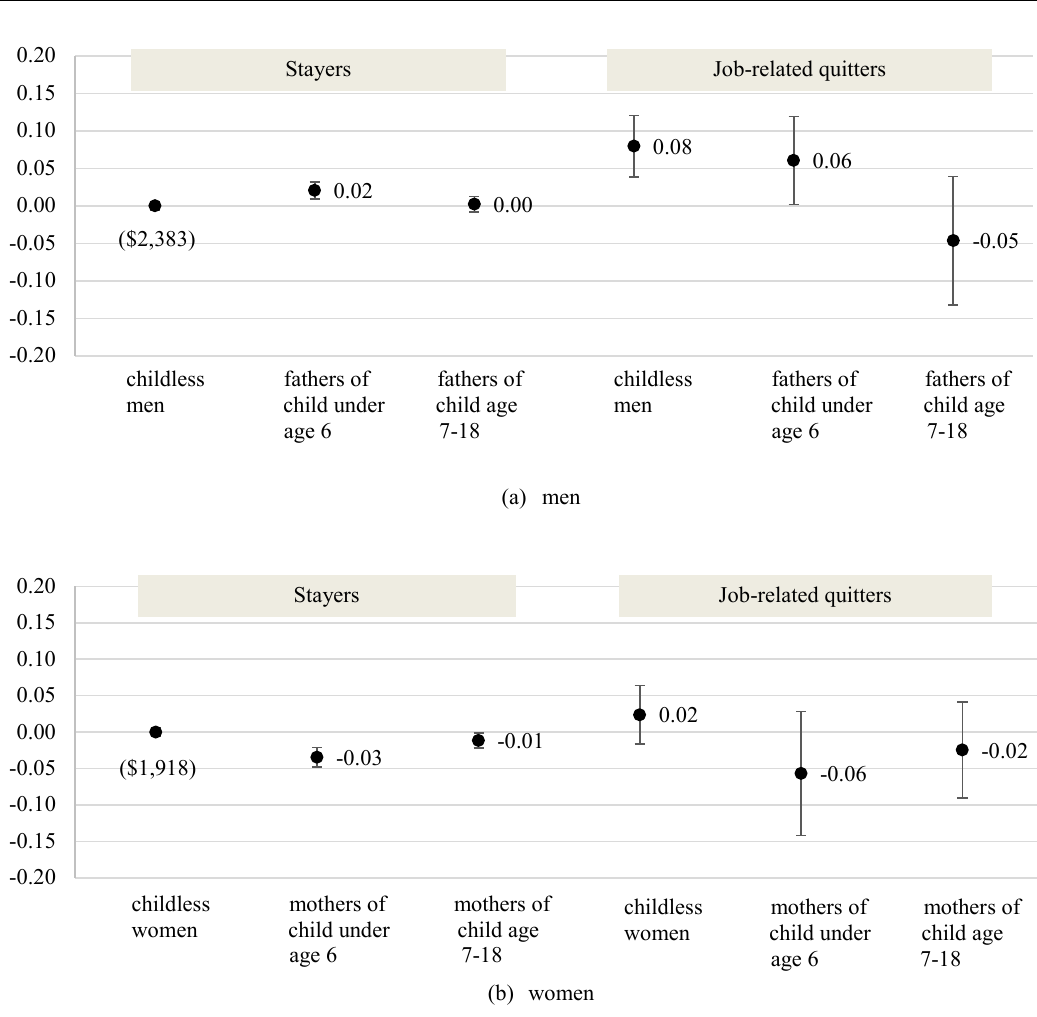
Figure 3. Differences in logged monthly earnings between childless stayers and other workers in the recession data